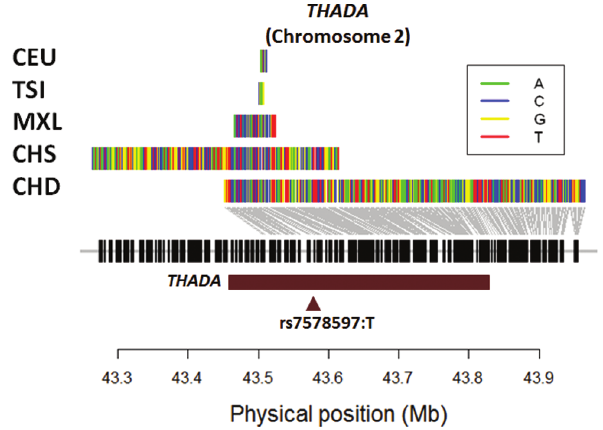
Figure 1. Long haplotypes around THADA in East Asian and European populations. Illustration of haplotype forms identified by haploPS that span the longest genetic distances around THADA (brown horizontal bar) on chromosome 2. Uncharacteristically long haplotypes were found at the same frequency of 45% in two East Asian populations (CHD, CHS) to span THADA , whereas at the same frequency, the longest haplotypes present in European populations (CEU, TSI, MXL) were comparatively much shorter. The haplotypes for the two East Asian populations also carried the thymine allele at rs7578597 that has been reported in association studies to increase the risk to Type 2